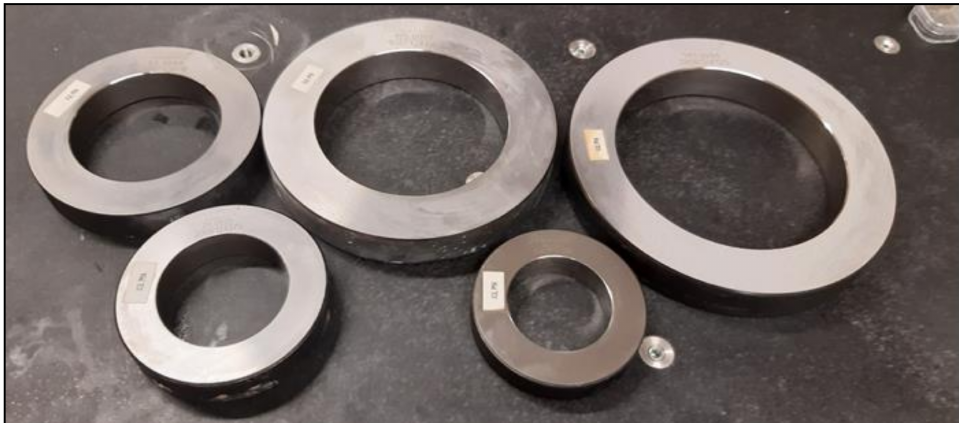
Figure 14. The used ring gauges for the validation of the digital